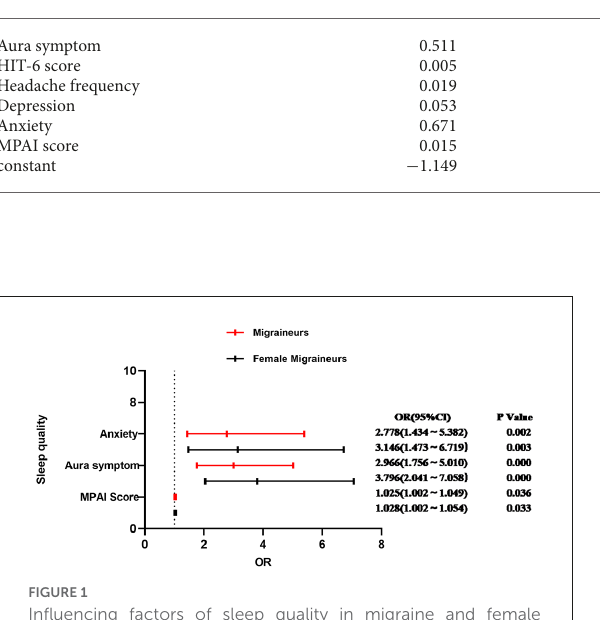
participants ( P > 0.05), but they affected the sleep quality of female participants and the effect was of statistical significance ( p < 0.05). Factors influencing sleep quality in migraine and female migraine patients are shown in Figure 1